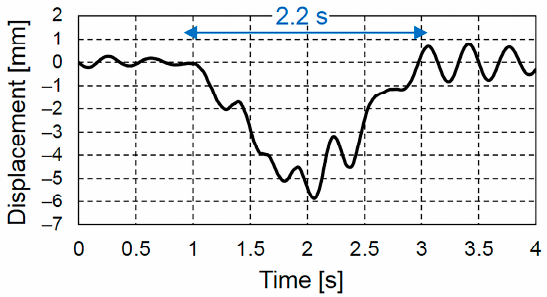
Figure 5. Displacement record at the longitudinal center of the lower flange of the main girder.